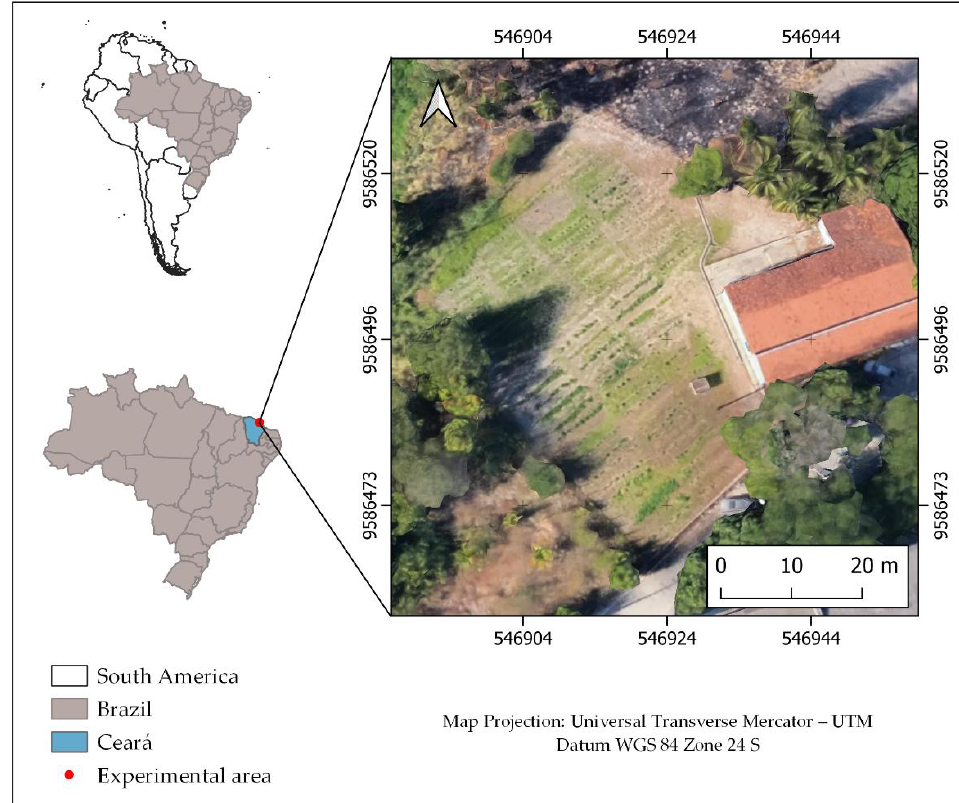
Figure 1. Location of the experimental area.